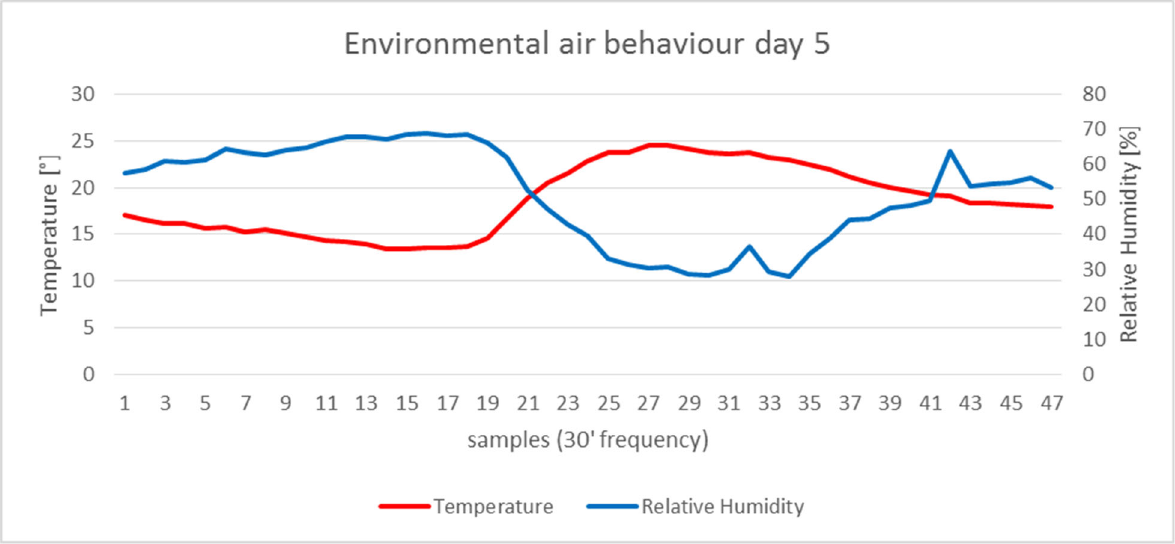
Figure 6. Environmental air temperature and relative humidity. Samples were collected with a frequency of 30 min (30 ′ ).